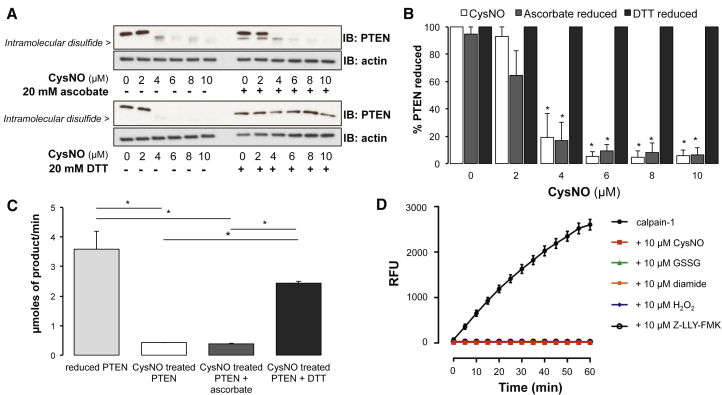
Functional Changes Regulated by Disulfides, Not S-Nitrosation(A) The oxidation state of PTEN was measured in SMCs treated with CysNO.(B) After exposure of CysNO, there was a decrease in reduced PTEN. Reduced PTEN was observed after reduction by DTT but not ascorbate.(C) PTEN’s enzymatic activity was inhibited after exposure to CysNO, as measured by in vitro phosphatase activity assay. Enzyme activity was restored after addition of DTT but not ascorbate.(D) Calpain-1’s enzymatic activity was inhibited in vitro after exposure to the nitrosating agent CysNO, the disulfide-inducing reagents GSSG, H2O2, or diamide, or the irreversible calpain inhibitor Z-LLY-FMK.Data are represented as mean ± SEM; ∗p < 0.05.